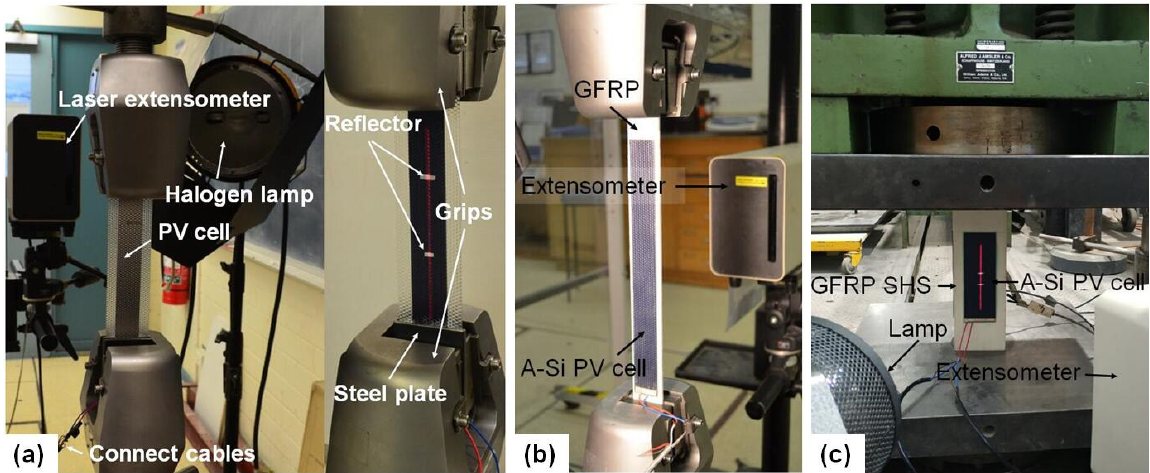
Figure 3. Experimental setup for ( a ) tensile test for a-Si PV cells, ( b ) tensile tests for integrations and ( c ) compressive tests for integrations.